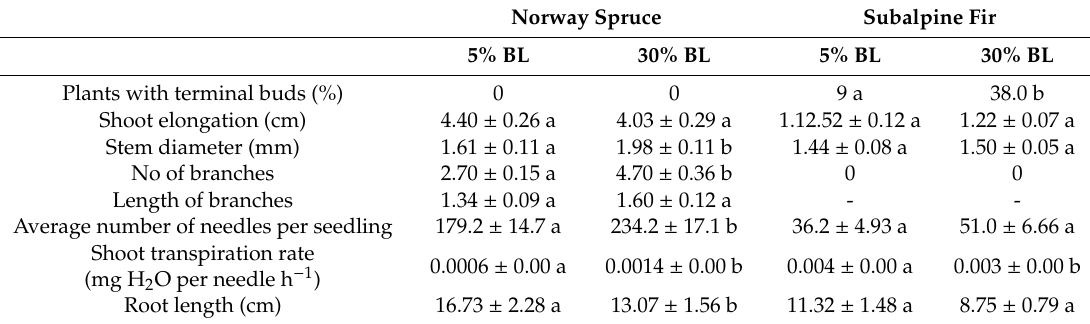
Table 2. E ff ect of the blue light (BL) proportion on the development of terminal buds, shoot elongation (cumulative growth), morphology, root length (cm), and transpiration rate of Norway spruce